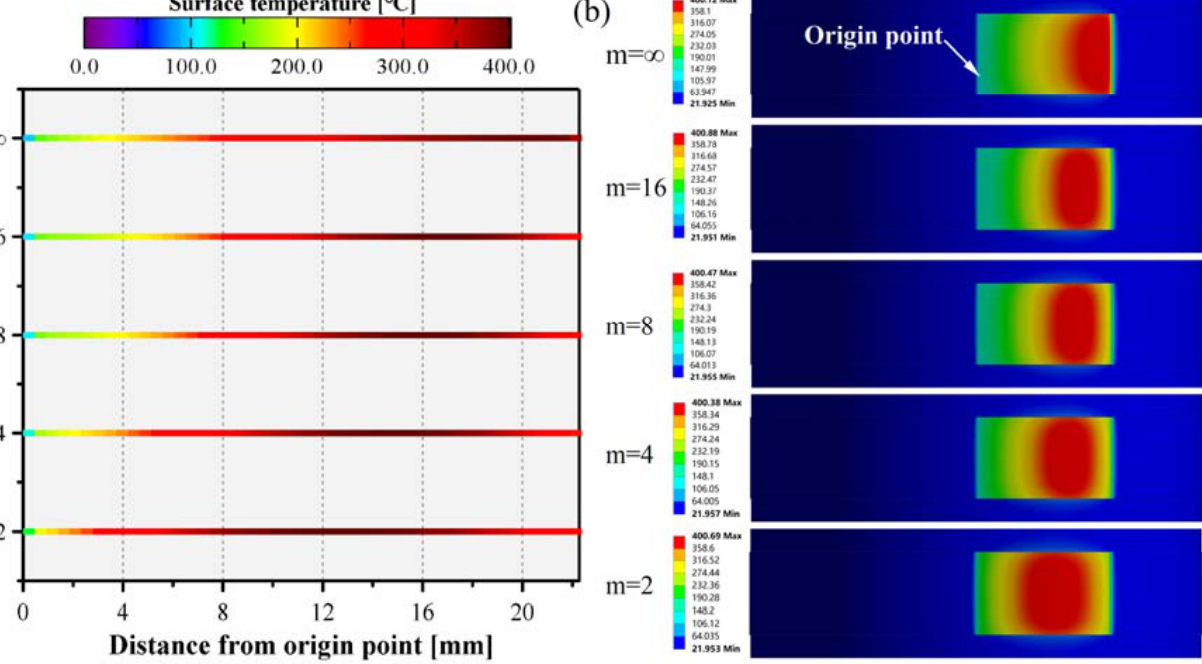
Figure 15. The influence of the exponent m on the heat flux distribution ( a ) and the distribution uniformity ( b ).